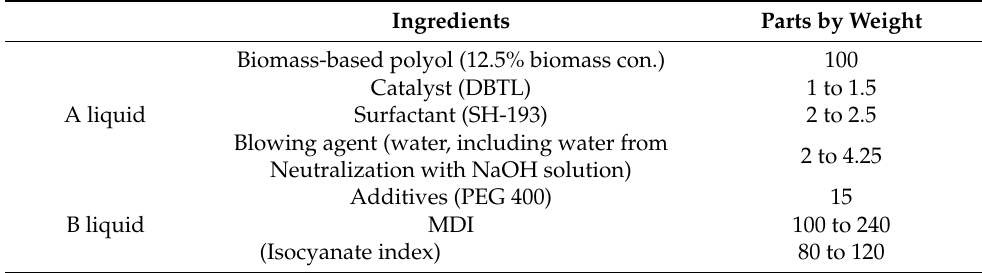
Figure 13. Mechanical properties of wheat straw derived biopolyol—formulated PU foams: ( a ) Compressive strength and ( b ) Young’s Modulus [98] . Additionally, the PU based on the 40% wheat straw-derived biopolyol presented an excellent biodegradability. At 30 days interval, the weight loss registered was 5.6 and 7.31% for the TDI and MDI formulations, respectively [98]. Polyurethane (foams) nanomaterials composites with cellulose nanocrystals (CNCs) as nanofillers are also presented in the literature [99]. The first step in their preparation was the liquefaction of rape straw under microwave irradiation using methanol and 3% H 2 SO 4 as a catalyst. The nonrenewable commercial polyol was replaced up to 40% (PU40) and nanocellulose was added as filler 1 to 6% [99]. Utilizing GC-MS analysis, the compo- sition of the polyols obtained under microwave irradiation was determined [99] (Figure 14). Both bio-polyol and cellulose nanocrystals were prepared from the liquid portion and solid residue of microwave-liquefied rape straw [99]. GC–MS, 1 H NMR, and FTIR